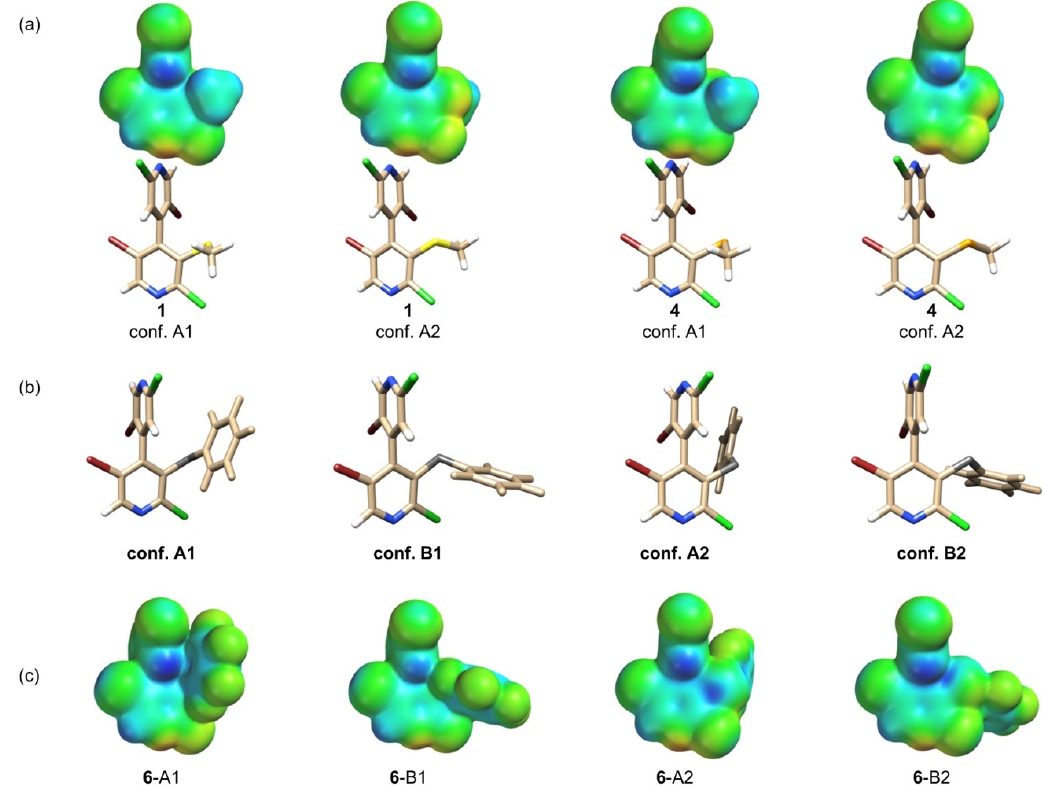
Figure 2. Conformations and related V S representations on electron density isosurfaces (0.002 au) graphically generated by using Spartan’ 10 (DFT/B3LYP/6-311G*): ( a ) V S representations and tube structures of conformers A1 and A2 calculated for compound 1 and 4 , ( b ) conformation motifs A1, B1, A2 and B2 computed for compounds 2 , 3 , and 6 , and ( c ) V S representations of conformers A1, B1, A2, and B2 of compound 6 ( V S representations for conformers of 2 , 3 , and 5 are depicted in Supplementary Information). Tube structures colors: bromine (red), chalcogen S/Se (dark grey), chlorine (green), hydrogen (white), nitrogen (blue), selenium (orange), sulfur (yellow). For the V S representations, colors towards red depict negative V S , while colors towards blue depict positive V S , and colors in between (orange, yellow, green) depict intermediate values.